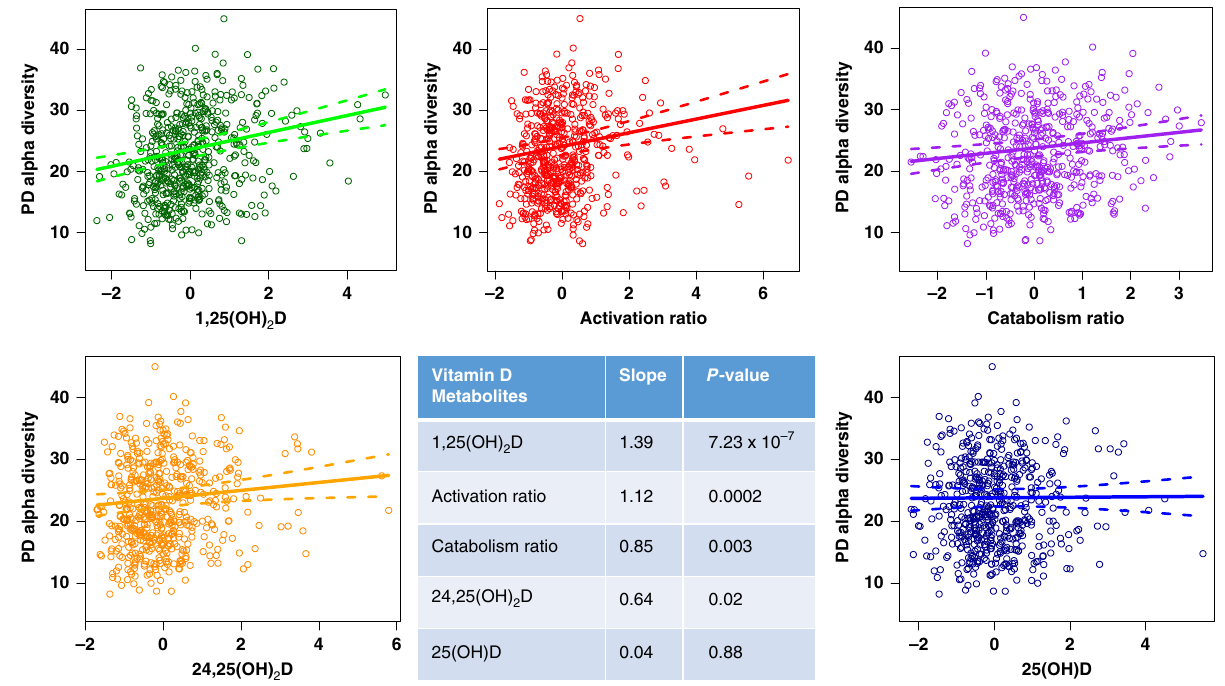
Fig. 3 Greater α -diversity is associated with higher 1,25(OH) 2 D levels and larger vitamin D activation and catabolism ratios. Multiple linear regression of each of the vitamin D metabolites and their activation/catabolism ratios in association with microbial α -diversity. Covariates are set at their mean for continuous variables and level with largest sample size for categorical variables. Slopes are the estimated slope coef fi cients corresponding to each vitamin D metabolites in their multiple linear regression models, and p-values are obtained from the ANOVA F-test in multiple linear regression. Source data are provided as Source data fi le: “ sourcedata_ fi gure3.xlsx ”